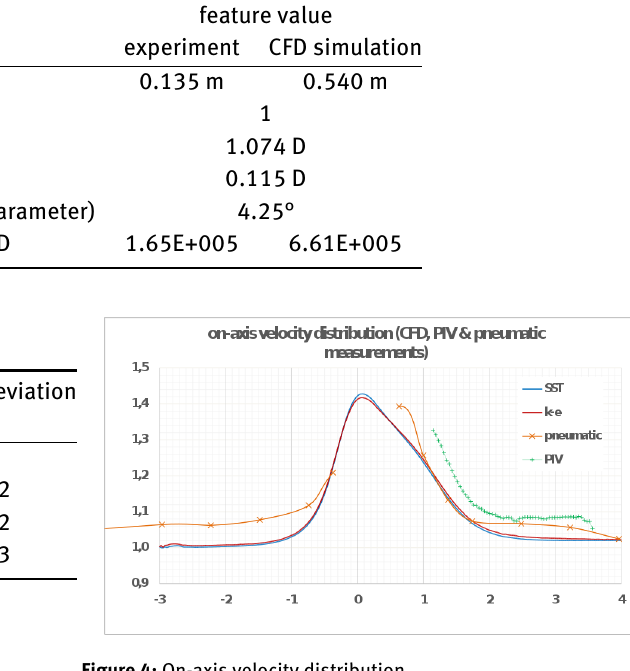
Figure 4: On-axis velocity